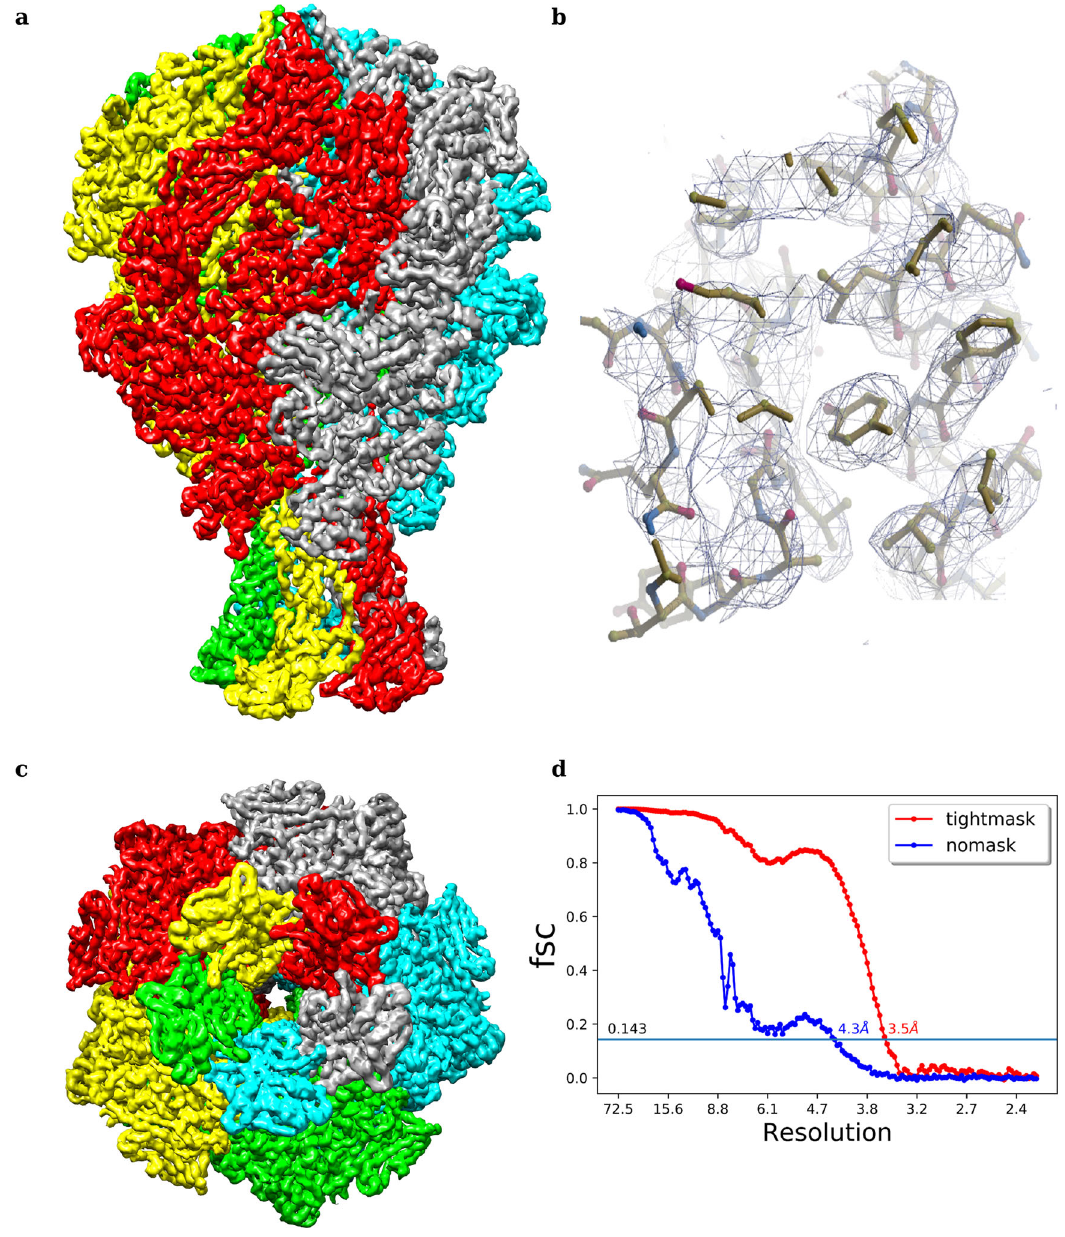
Fig. 4 3D EM density map of TcdA1 obtained by implementing additional re fi nement steps to the uniform pipeline scheme. a Side view, b highlighted view of the side chains fi tted (PDB 1VW1) into the EM density, c top view, and d FSC curve for TcdA1 showing resolution ( Å ) at gold standard cutoff